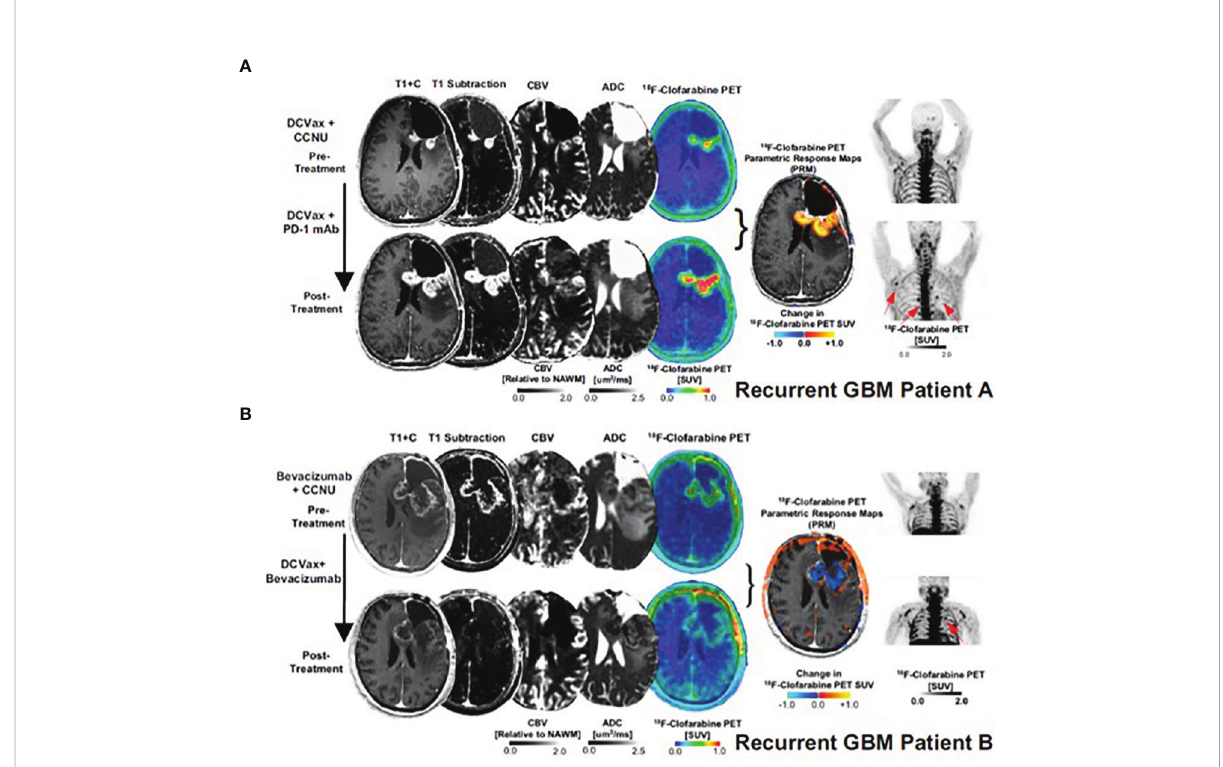
FIGURE 4 [18F]CFA PET and advanced MRI fusion images of two GBM patients (A, B) treated with dendritic cell vaccination and anti-PD-1